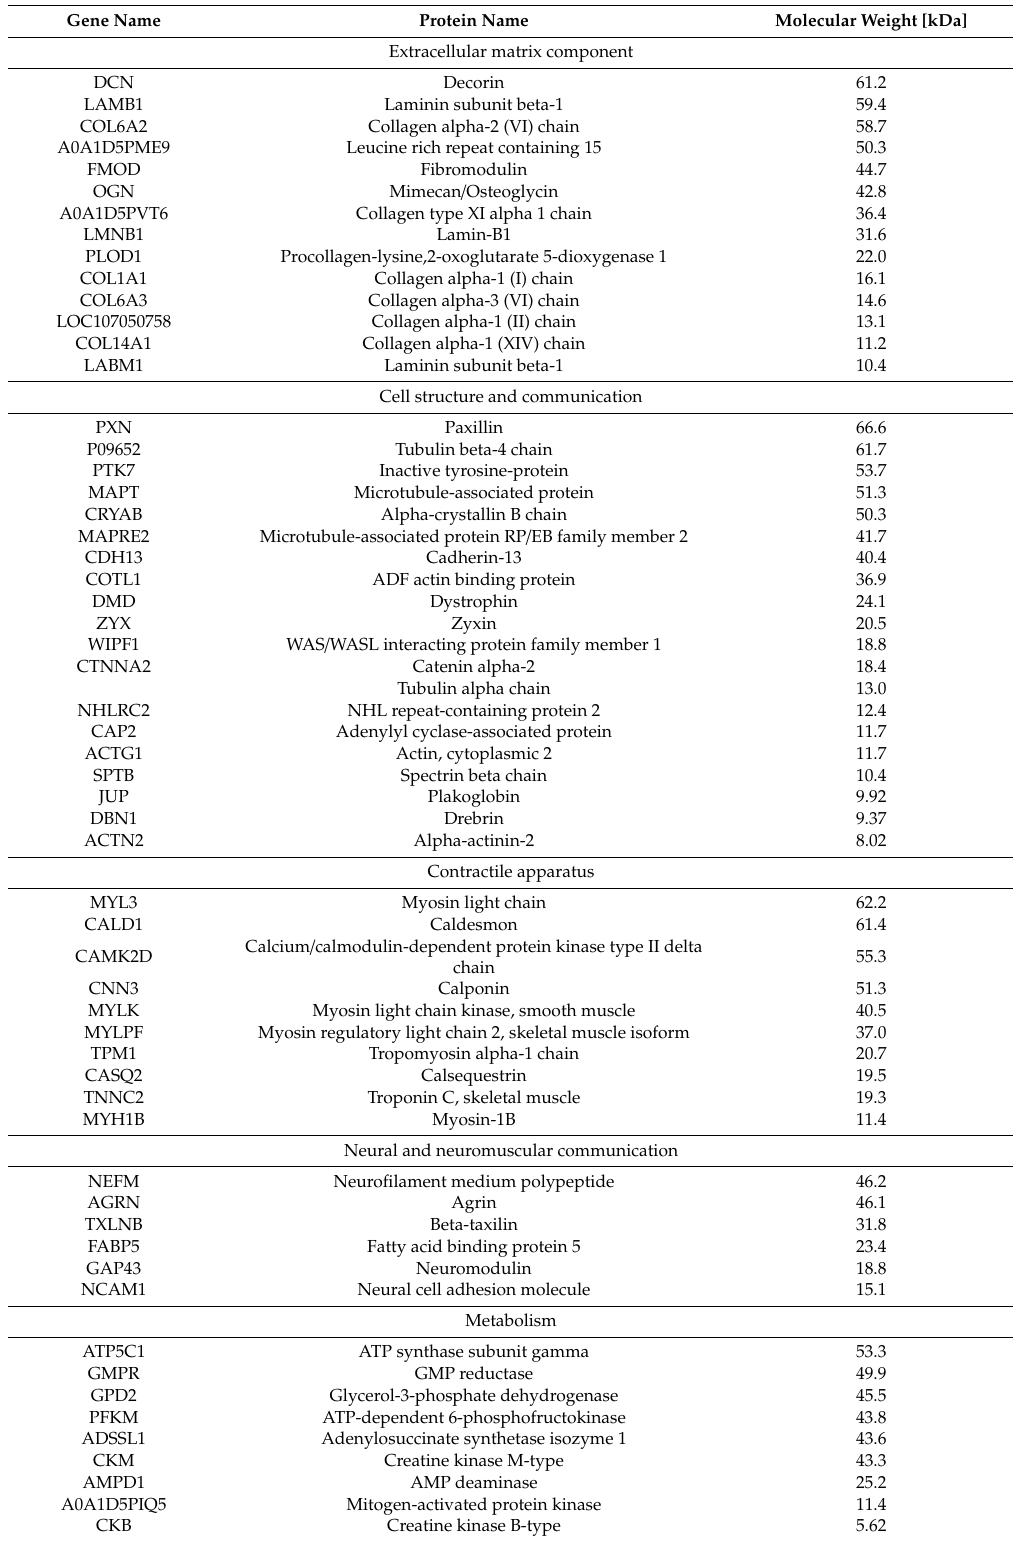
Table 1. Selected top proteins (59) from chicken embryo muscle extract specific for muscle cell